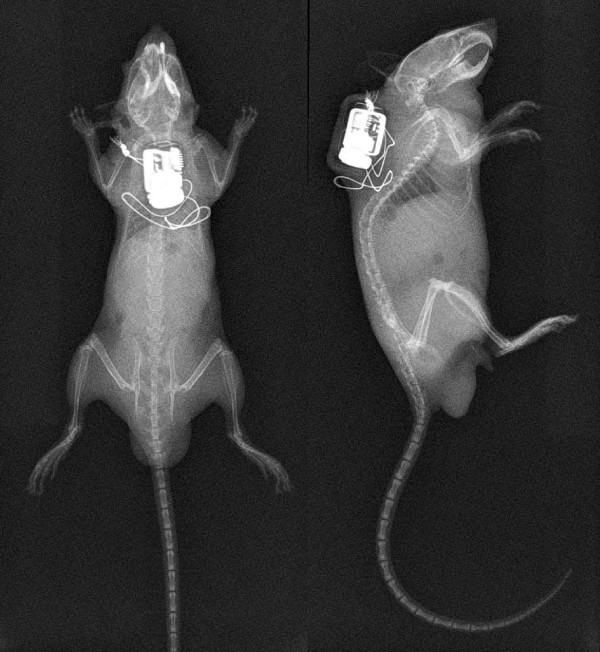
Radiographs showing the position of the telemetry transmitter from a dorsal (left) and lateral (right) viewpoint. The transmitter body was placed in the midline of the mouse's back and fixed with surgical stainless steel sutures.